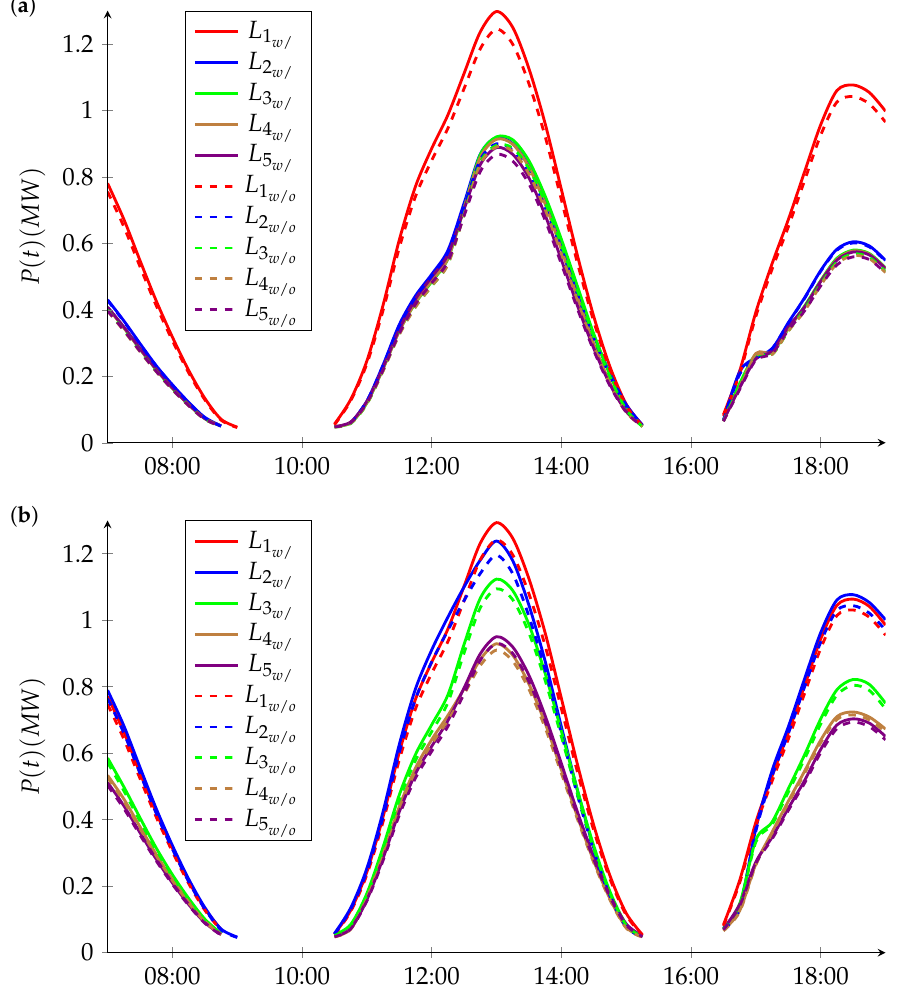
Figure 10. Time-series of output per row of turbines with (solid lines, curves captioned “w/”) and without blockage corrections (dotted lines, curves captioned “w/o”). ( a ) Aligned and ( b ) staggered layouts. Note that rows/lines of turbines are ordered with respect to the incoming flow. Thus, line 1 refers to the line of devices facing the ebb and peak flow whereas line 5 refers to the last line of the turbine